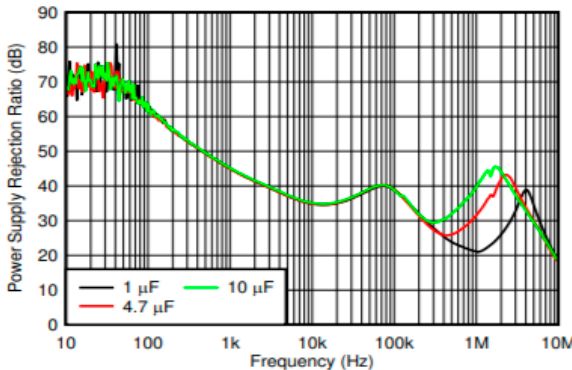
Figure 4. PSRR vs. C OUT at V OUT = 3.3 V and I OUT = 1 A [14].